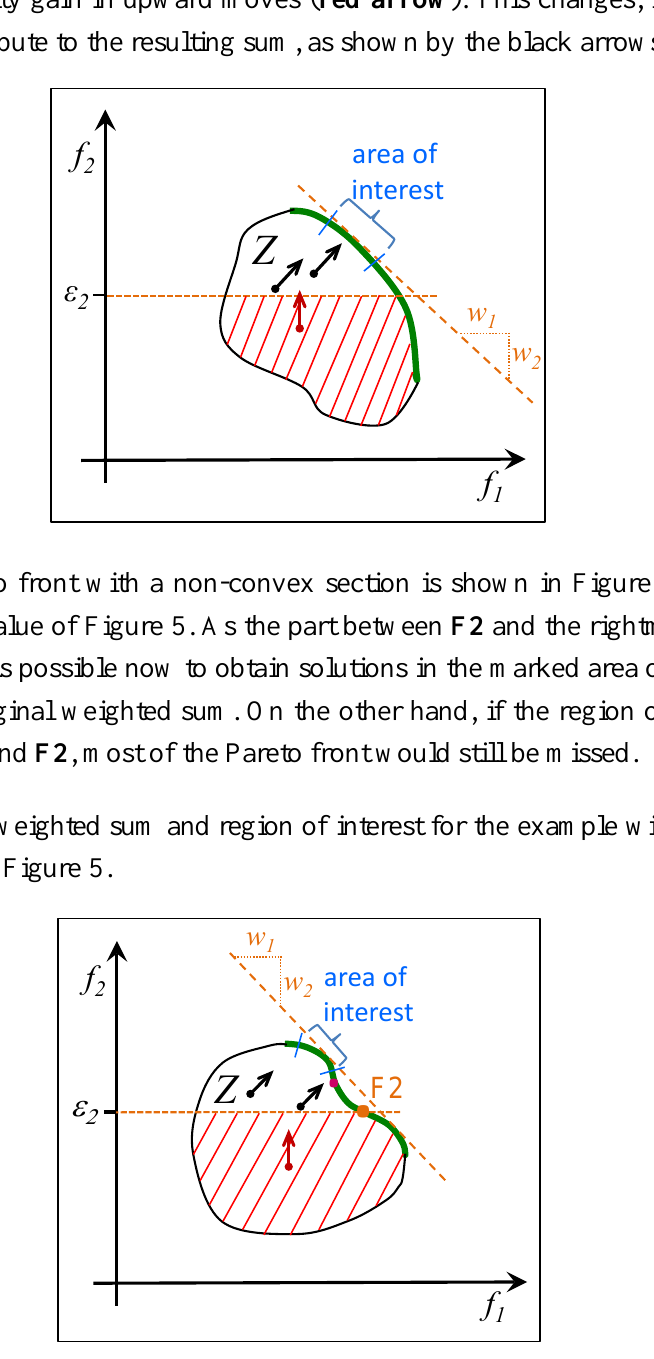
only and will 2 is exceeded 2